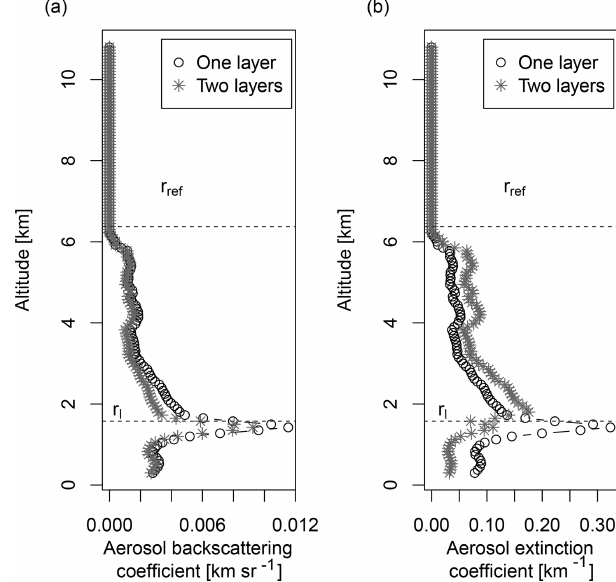
Figure 12. Example of the extinction and backscattering coef- ficients under dust conditions obtained by using one- and two- layer methods applied to a lidar profile made on 5 August 2013 (AOD SCO = 0 . 46). Upper limits of the MBL ( r l ) and FT ( r ref ) are represented by horizontal dashed